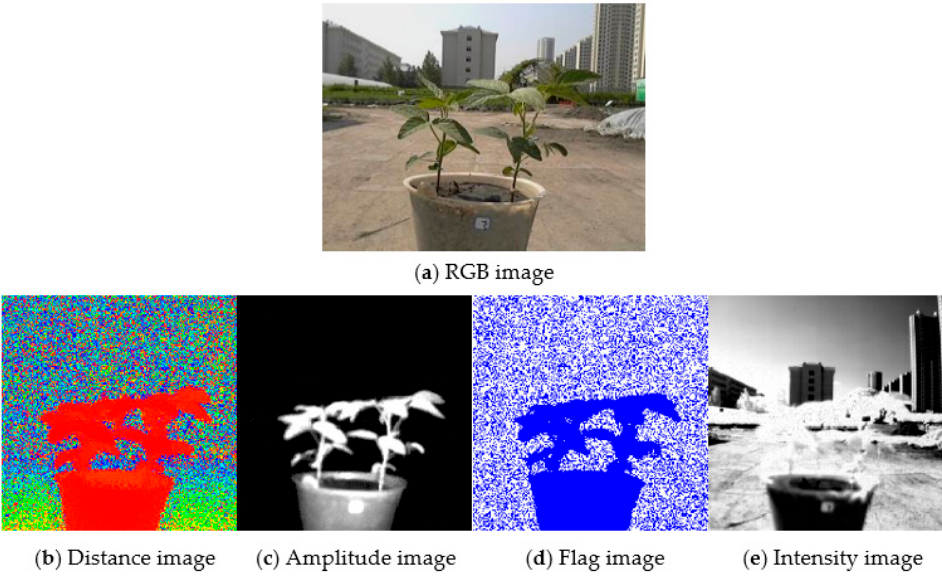
Figure 2. Multisource imaging system used in the soybean field. Figure 3. Multisource images acquired using the multisource imaging system. Figure 3. Multisource images acquired using the multisource imaging